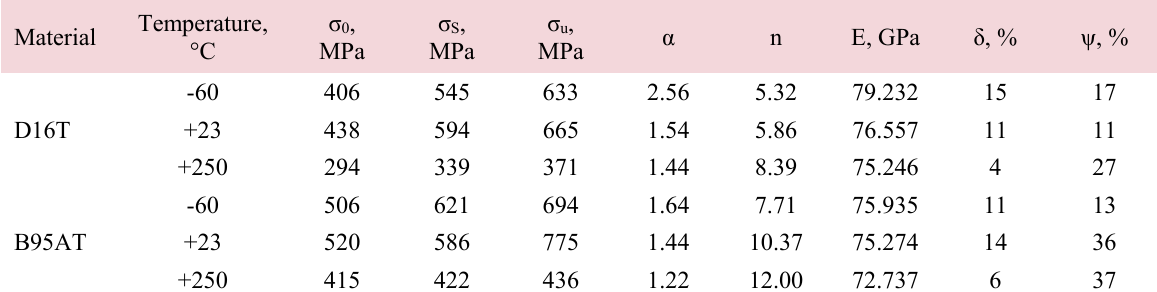
Table 1: Main mechanical properties of aluminum alloys under different temperature.